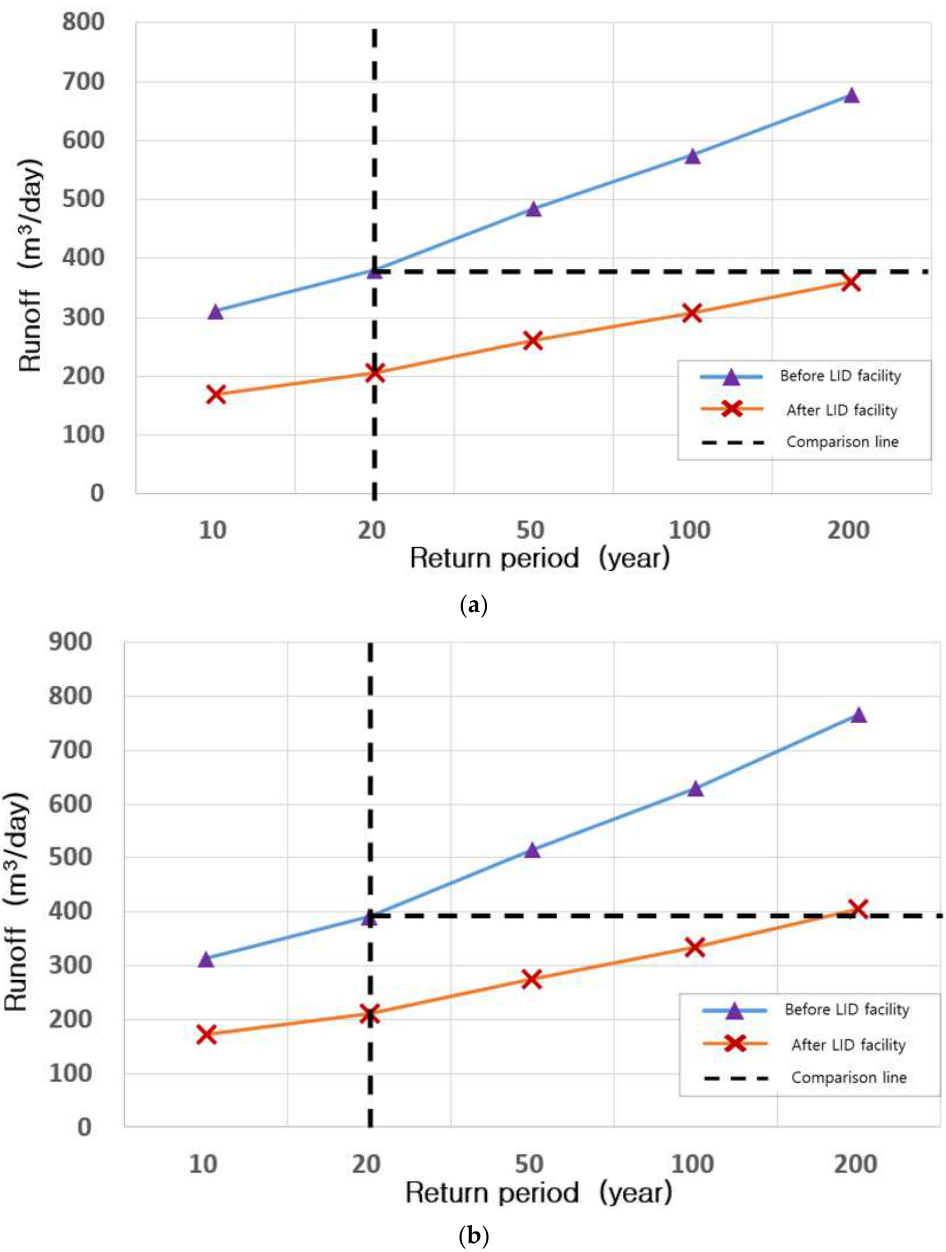
Figure 11. Change in runoff by return period in RCP 8.5 scenario: ( a ) 1988–2050 (year); ( b ) 1988– 2100 (year).